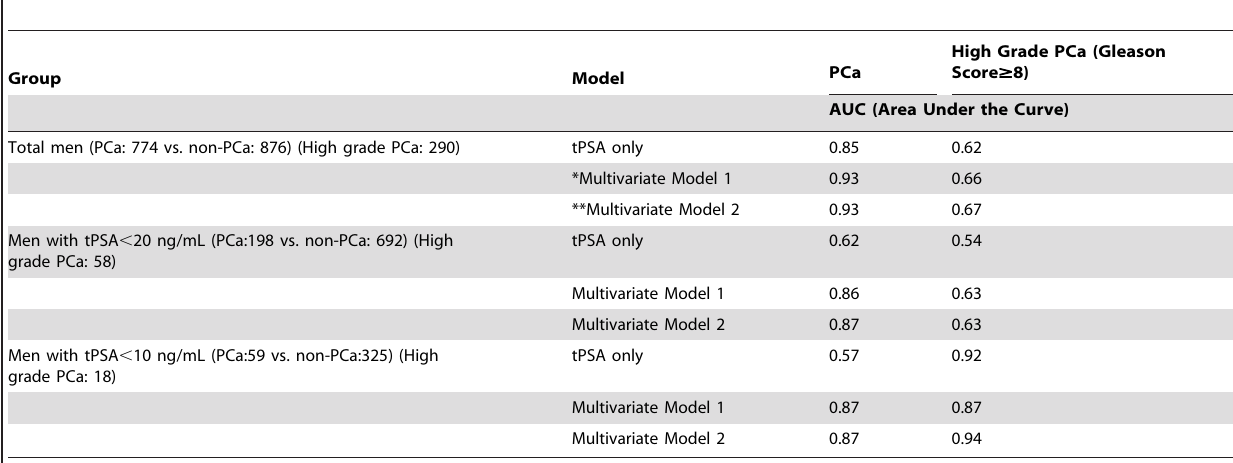
Table 3. Performance of tPSA only and Multivariate model for predicting PCa and high grade PCa in different stratification.